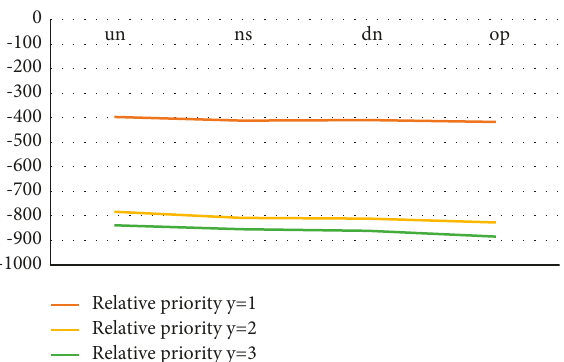
Figure 3: Ranking results using an extended COPRAS method with LFFWDHM.